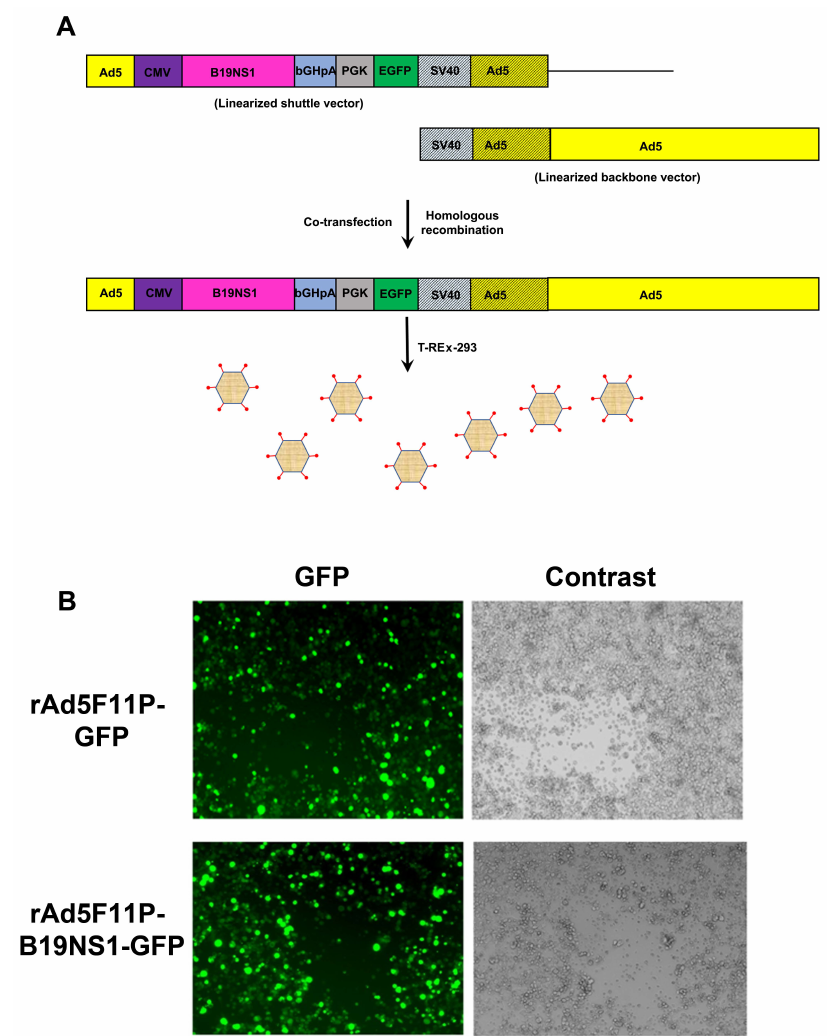
Figure 3. Production of recombinant adenovirus expressing GFP and B19NS1-GFP. ( A ) The schematic flowchart of recombinant Ad production. Both the Ad shuttle and proviral backbone plasmids are transfected into cells. After homologous recombination, a rAd proviral genome is generated, which further replicates to produce rAd virions as diagramed. ( B ) Recombinant